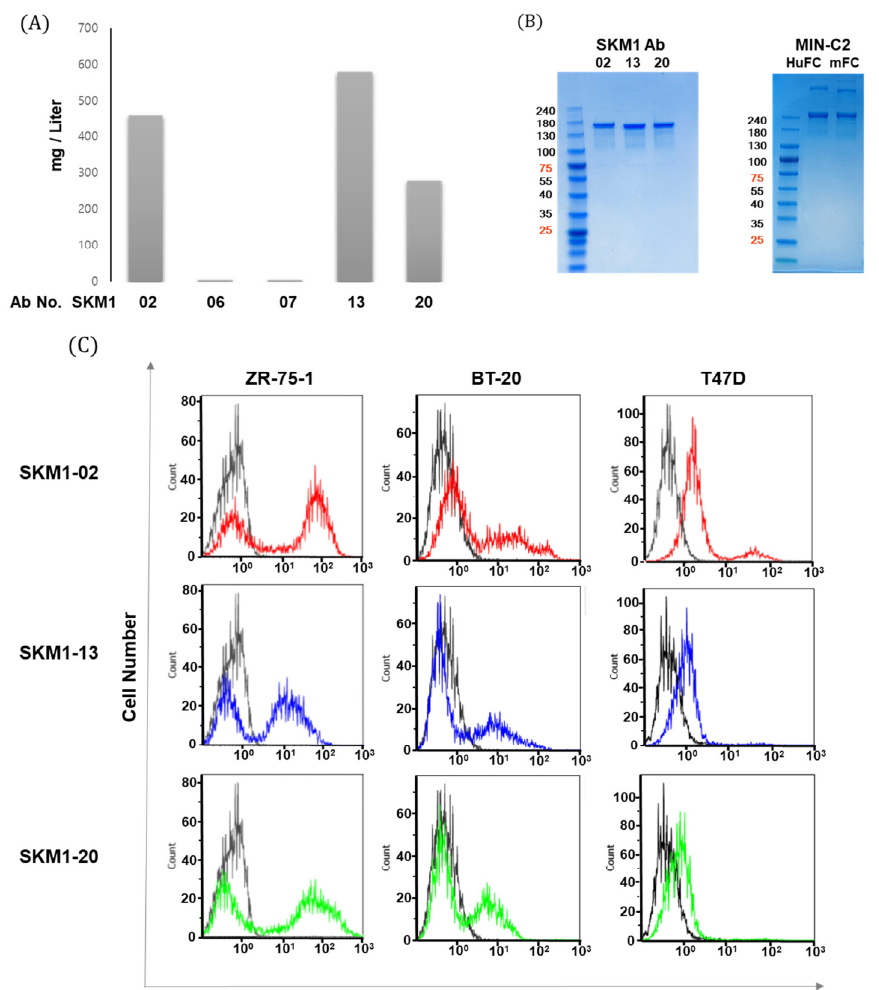
Figure 3. MUC1-C specific antibody generation and binding of MUC1 expressed breast cancer cells. ( A ) Comparison of transient expression levels of different IgG constructs in Expi-CHO cells harvested after 12 days, the antibodies were purified via protein A column chromatography. Each IgG antibody is expressed as mg per 1 L culture. ( B ) Coomassie blue staining showed purified SKM1 antibodies (left panel) and MIN-C2 antibody (right panel). Antibodies transiently expressed from Expi-CHO cells were purified after 12 days using a protein A column and showed expression with SDS-PAGE. For comparison with the reference antibody, MIN-C2 developed by Minerva Biotechnologies was constructed and expressed as IgG1 with either Human Fc or Mouse Fc sequences. ( C ) Specific interaction between SKM1-02, -13, or -20 Ab and MUC1 on breast cancer cells. MUC1 levels in breast cancer were measured by flow cytometry with 2nd antibody (black line) or candidate antibodies; SKM1-02 (red line), SKM1-13 (blue line), SKM1-20 (green line).